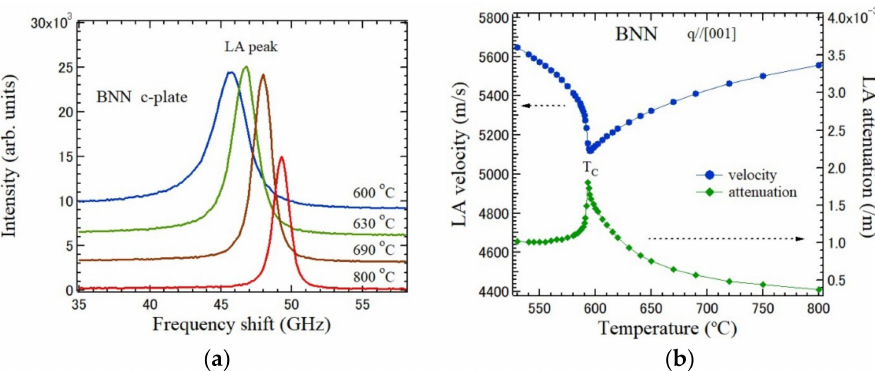
Figure 7. Temperature dependences of ( a ) Brillouin scattering spectra of a c -plate of BNN in a paraelectric phase, and ( b ) sound velocity and attenuation of the LA mode along the c -axis of BNN